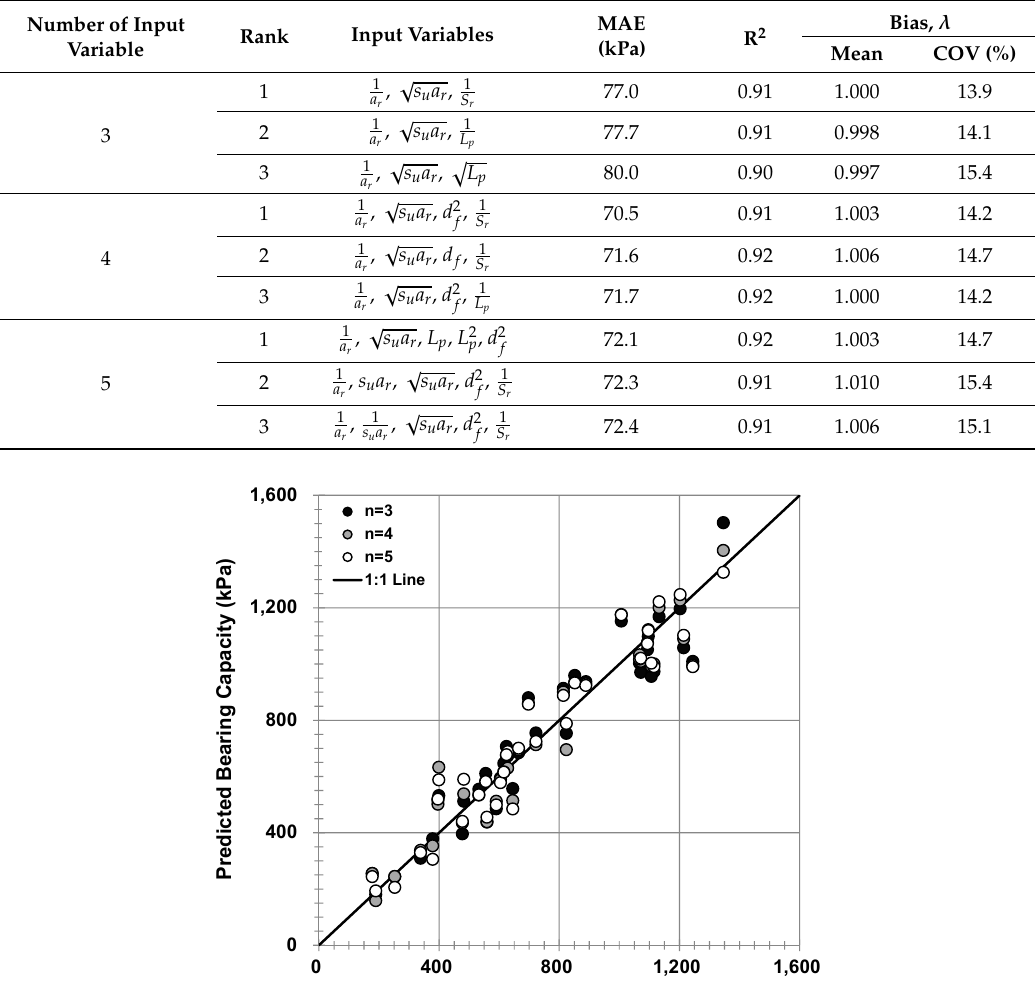
Table 3. Estimation of the prediction error by cross-validation.